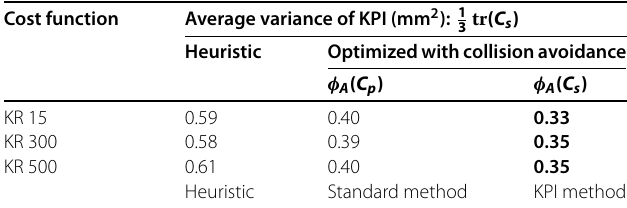
Table 6 Key performance indicator (KPI) average variances (mm 2 ) of three KUKA robots with heuristic and optimized experimental designs for parameter